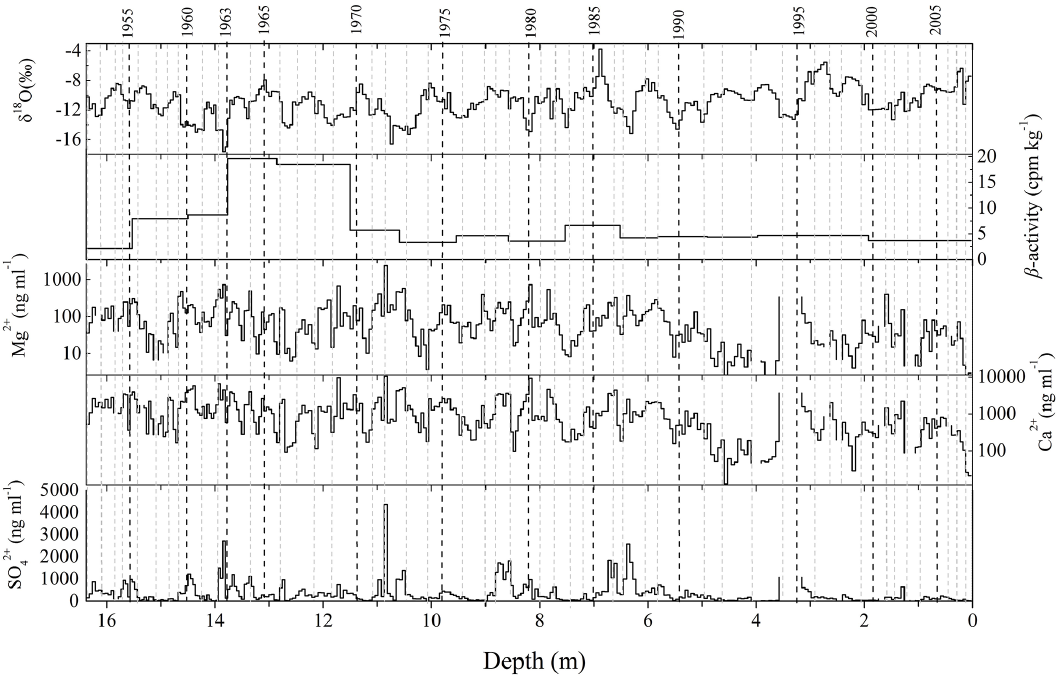
Figure 2. Variations of δ 18 O in the ZK ice core and other data used for dating, including beta activity and major ion concentrations. We calculated the logarithm to the base 10 for the concentrations of the Ca 2 + and Mg 2 + to facilitate